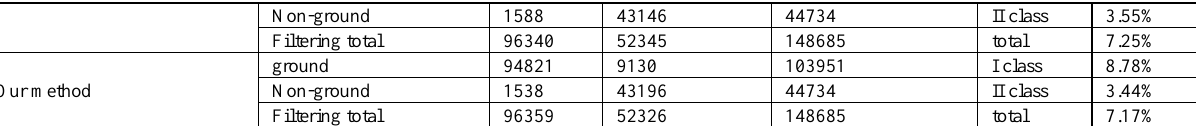
Table 3. Filtering results of crop land